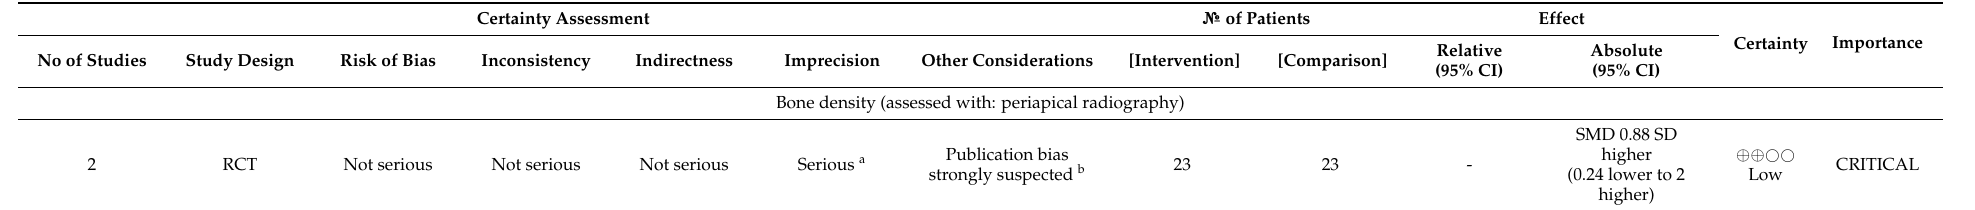
Table 5. Summary of the quality assessment using the GRADE approach of outcomes included in the meta-analysis of L-PRP. Certainty Assessment